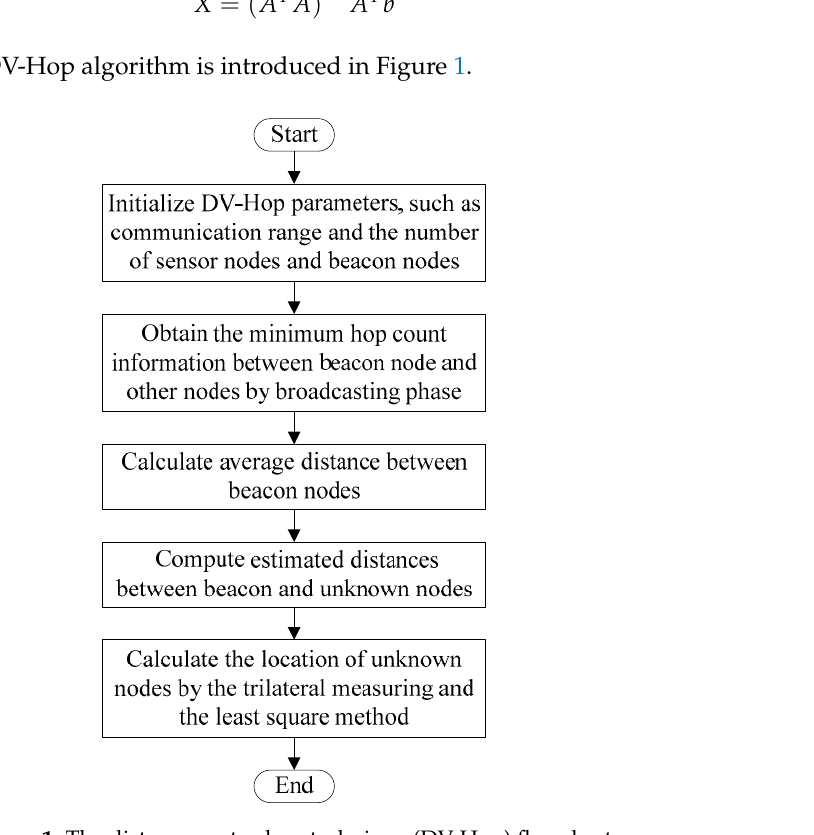
Algorithm 1 ： The pseudo-code of NSGA-II